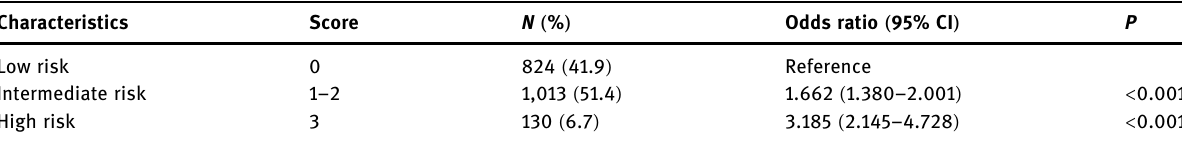
Table 4: Risk - strati fi cation scoring system of breast cancer